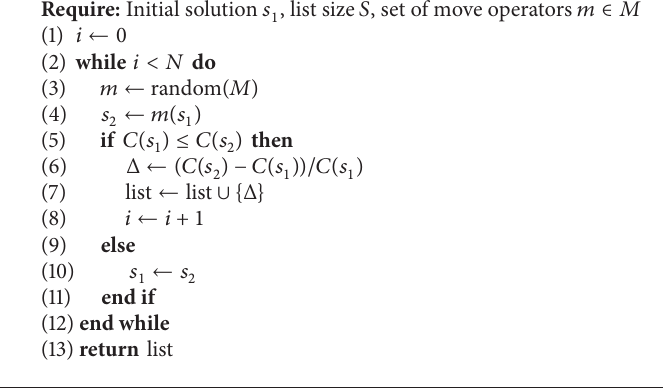
Algorithm 1: Creating the list of threshold